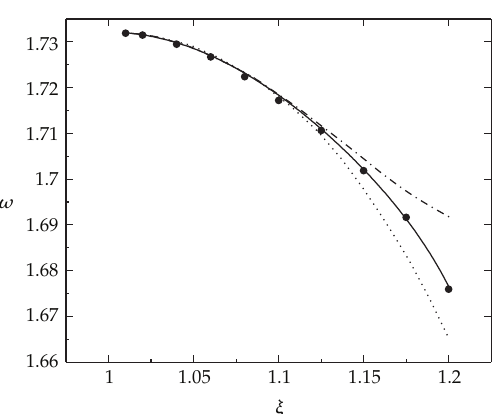
Figure 5: Comparison of the 1st, 2nd, and 5th-order HAM approximations of ω with the numerical results (cid:3) α (cid:9) 1, θ (cid:9) 0 . 999939, h (cid:9) − 2 . 3 (cid:4) . Symbols: Runge-Kutta numerical results; dotted line: 1st-order; dash-dotted line: 2nd-order; solid line: 5th-order.